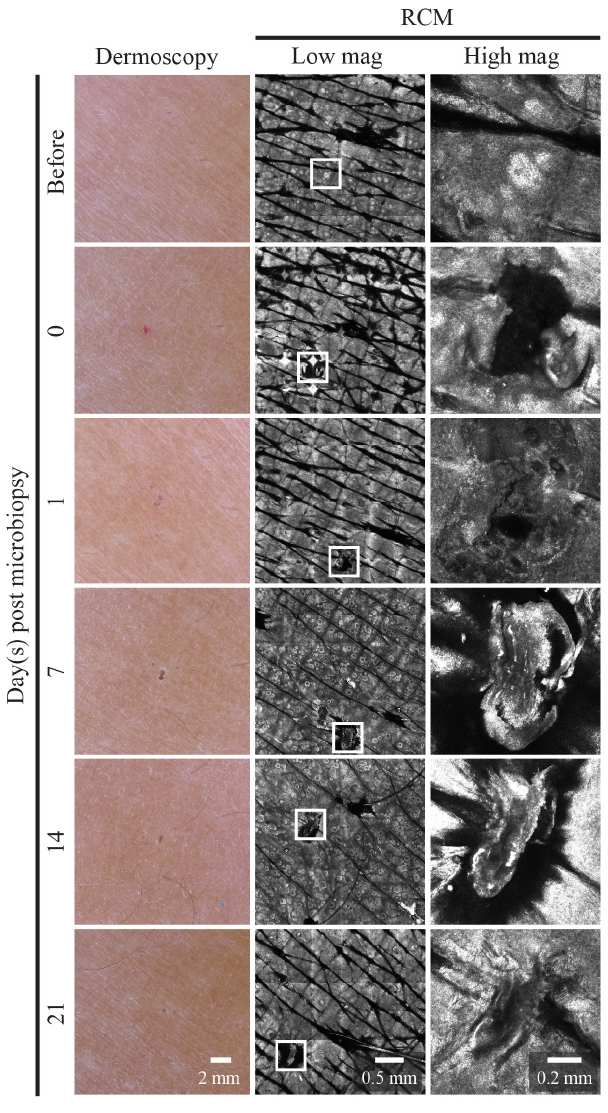
Figure 6. Wound healing kinetics of microbiopsy site . The left column shows dermoscopic images of the microbiopsy site over time. The middle and right column are mosaics and at 30x magnification reflectance confocal microscopy (RCM) images, respectively, of the microbiopsy